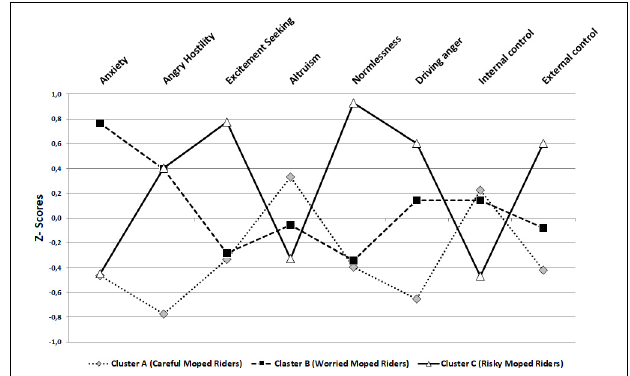
FIGURE 1 | Profile plot of the three clusters of moped riders identified.